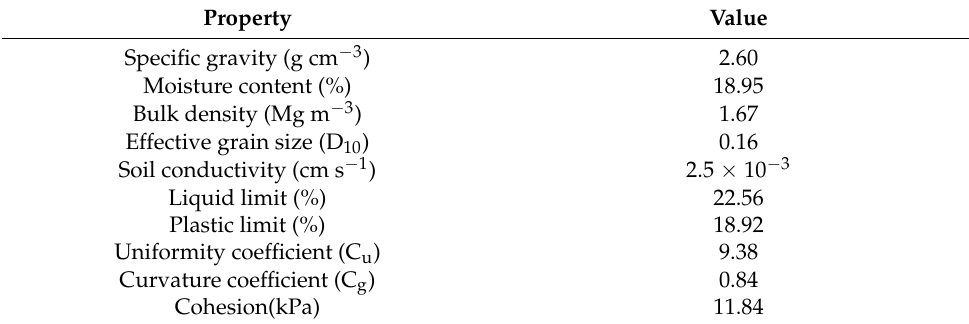
Table 1. Physical properties of the soil used in flume tests.